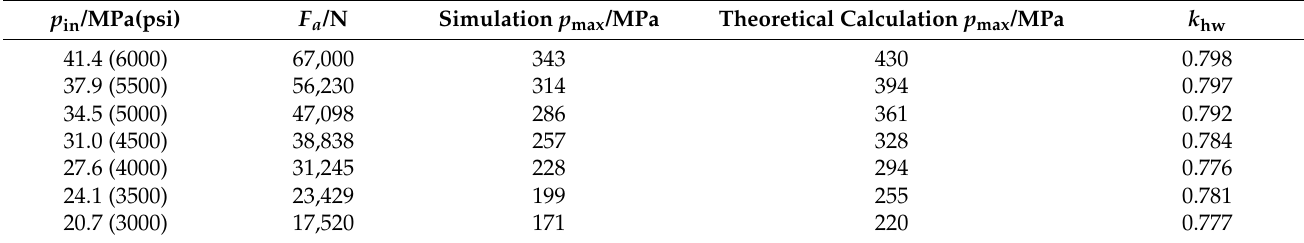
Table 4. Correction coefficient k hw under different pressures (water depth pressure 0).